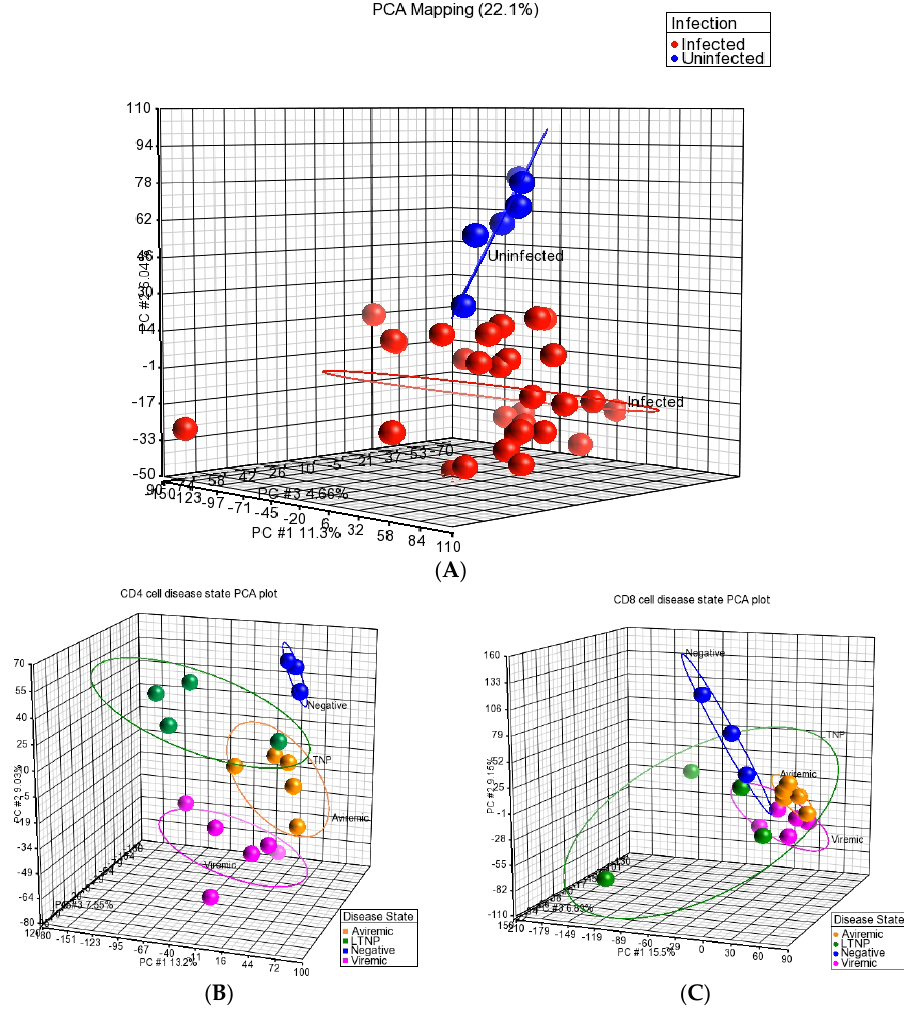
Figure 1. ( A ) Principal component analysis (PCA) of samples highlighting concordance and clustering of all infected cell samples, compared to uninfected samples. X Axis (Component 1) = 11.3%, Y Axis (Component 2) = 6.04%, Z Axis (Component 3) = 4.66%. Red = HIV-positive (HIV+), Blue = HIV-negative (HIV–), healthy donors; PCA of CD4+ ( B ) and CD8+ ( C ) T-cells respectively, highlighting disease group concordance. Pink = viremic, Yellow = aviremic, Green = LTNP, Blue = negative. Viremic n = 6, aviremic n = 5, LTNP n = 4, negative n = 3 for each cell type. ( B ) X axis (Component 1) = 13.2%, Y axis (Component 2) = 9.03%, Z axis (Component 3) = 7.55%. ( C ) X axis (Component 1) = 15.5%, Y axis (Component 2) = 9.15%, Z axis (Component 3) =